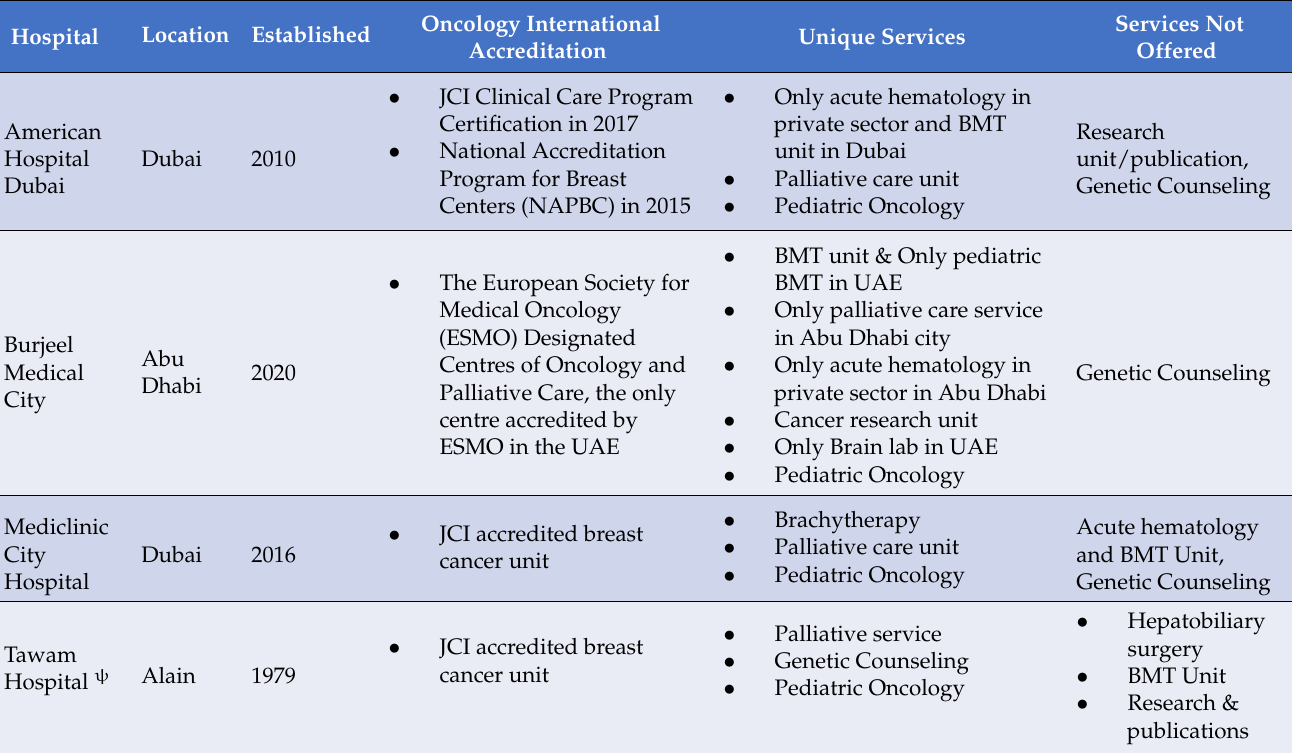
Table 5. Established comprehensive cancer centers in the